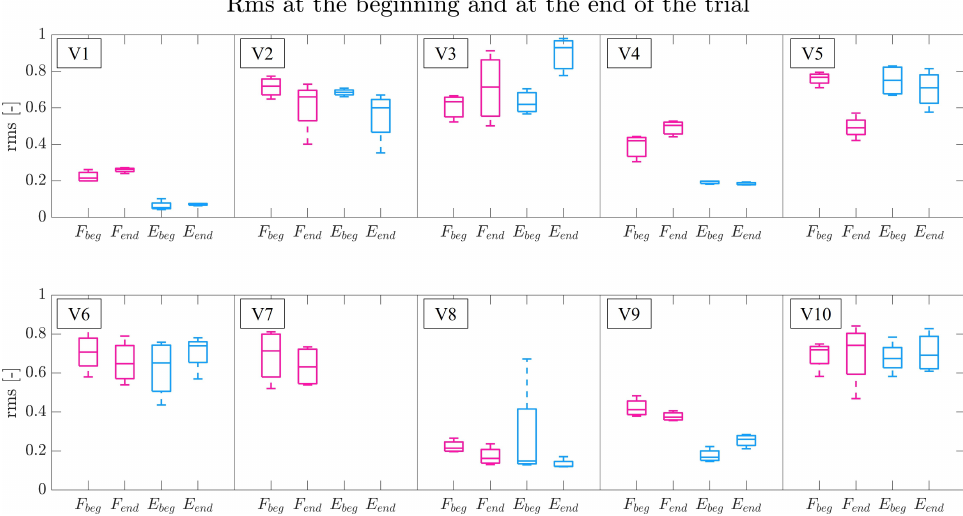
Figure 9. Root mean-square level (rms) of EMG signals for each volunteer (V). F beg and F end are the indices computed on flexor digitorum superficialis (in magenta), and E beg and E end were computed on extensor digitorum communis (in light blue), at the beginning and the end of the trial, respectively. The middle line is the median of four trials in the same experimental conditions, the edges of the box are the 25th and 75th percentiles, and the whiskers extend to the most extreme data points not considered